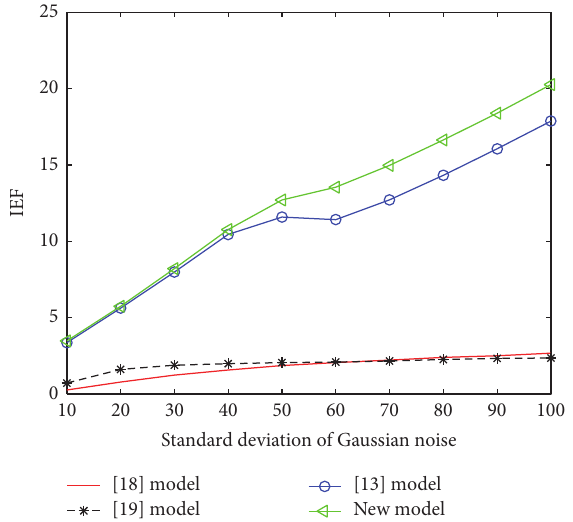
Figure 14: IEF graph of [13, 18, 19] and new algorithms for various Gaussian noise for Bus video